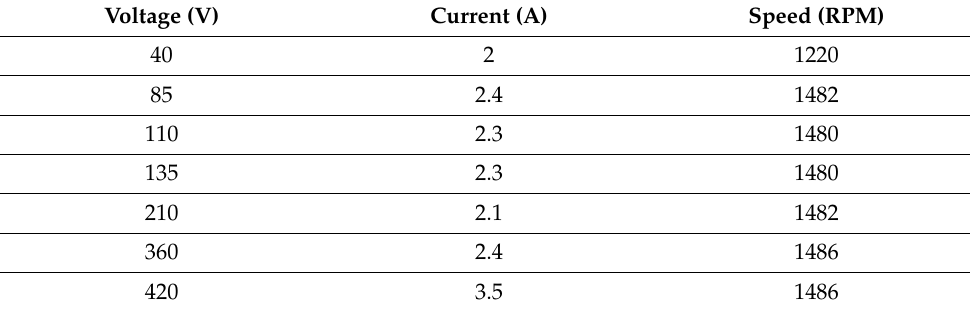
Table 5. Speed performance in no load condition.